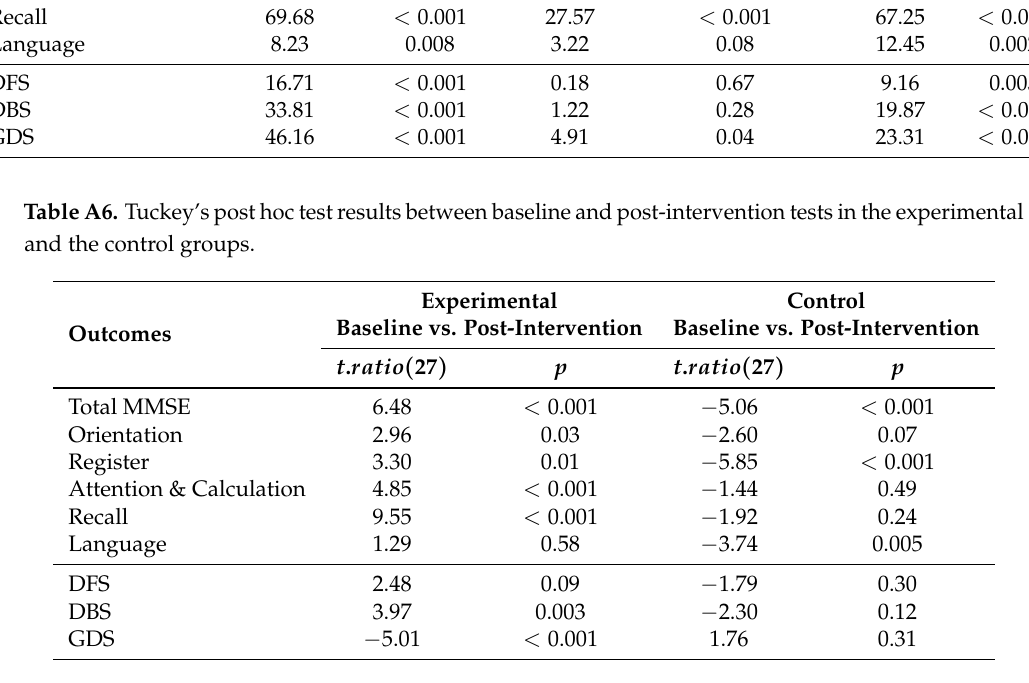
Table A7. Tuckey’s post hoc test results between the experimental and the control groups in baseline and post-intervention